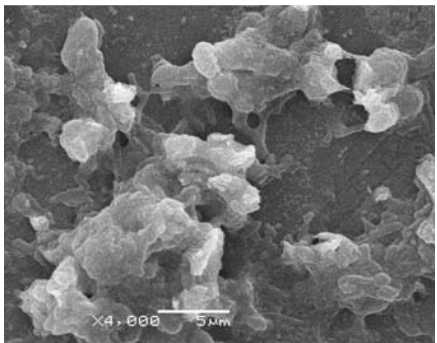
Figure 3. Human bone marrow mesenchymal stem cells (hBMSCs) differentiate to osteoblast on the TCP ceramic